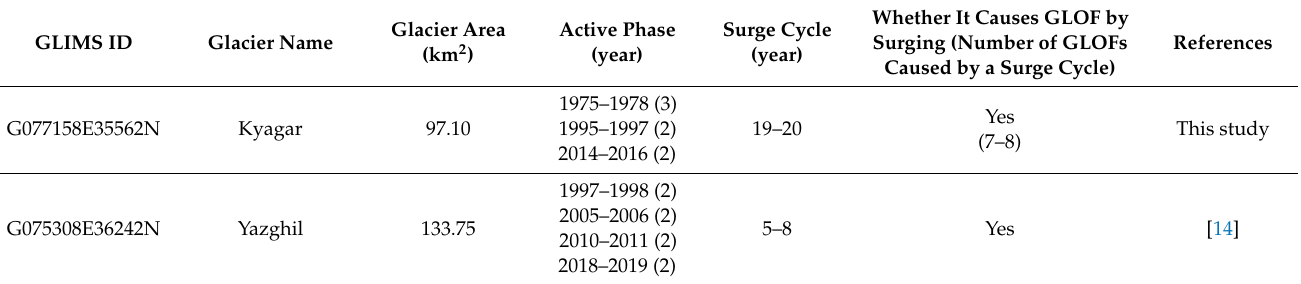
Table 4. Characteristics of Karakoram surging glaciers observed to have surged at least